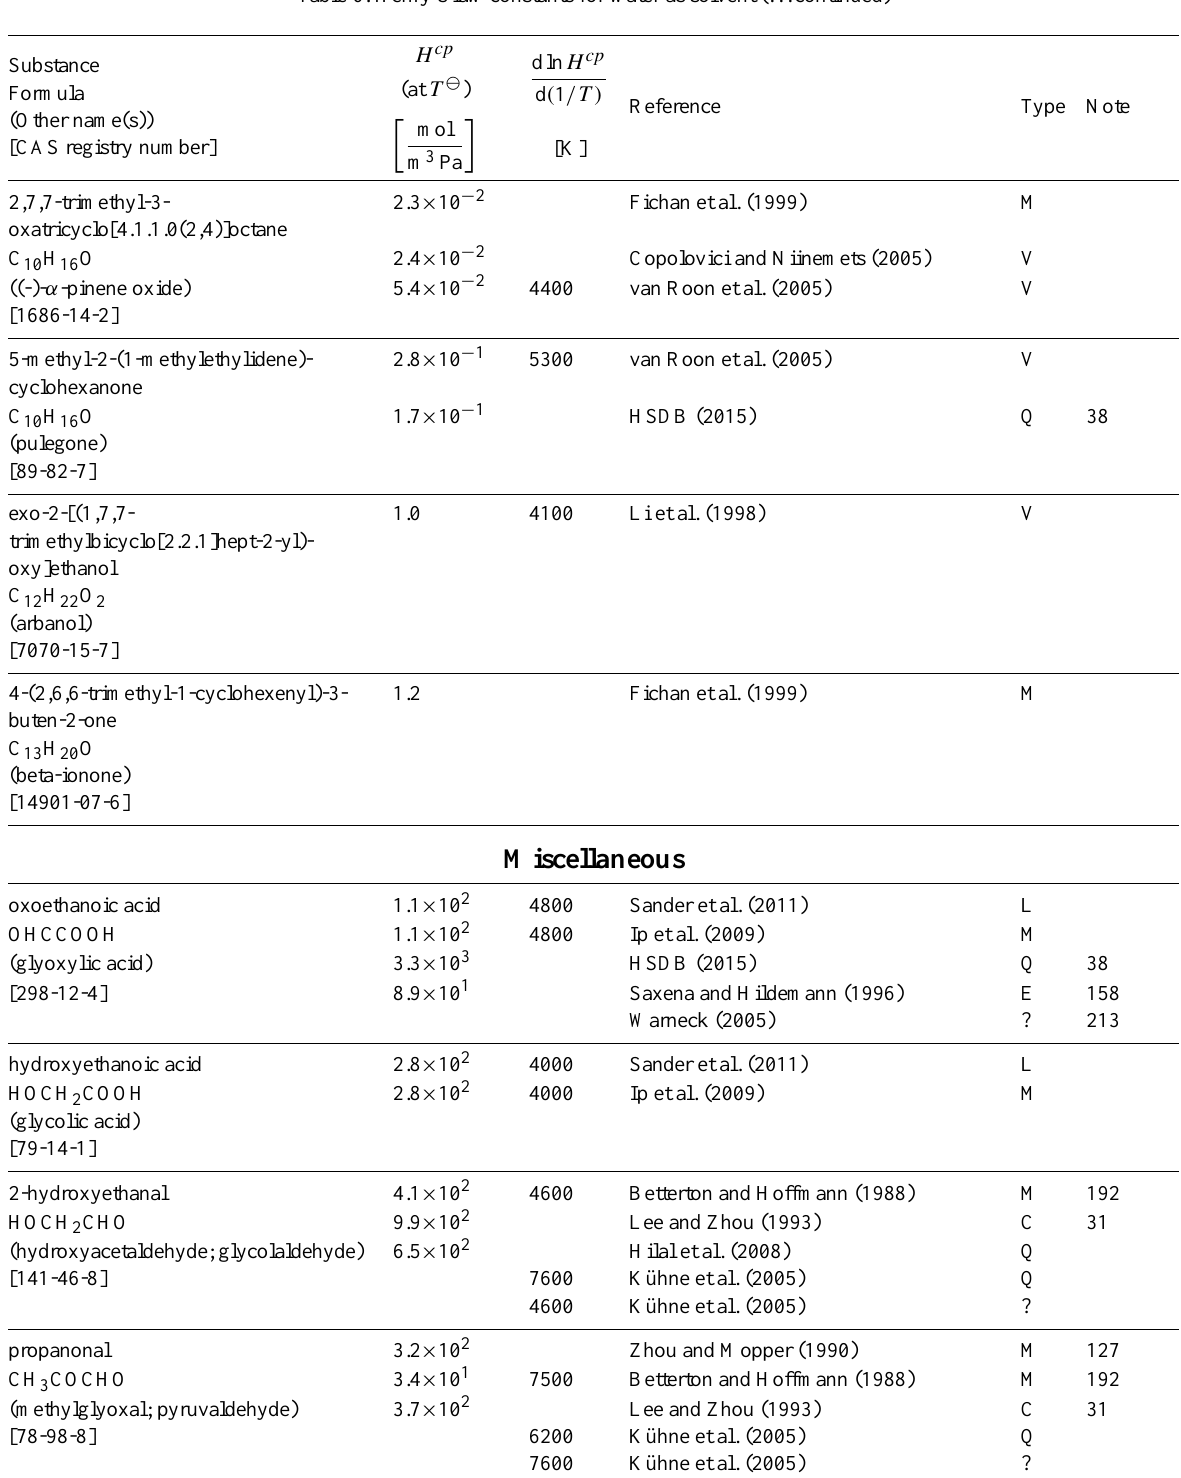
Table 6: Henry’s law constants for water as solvent